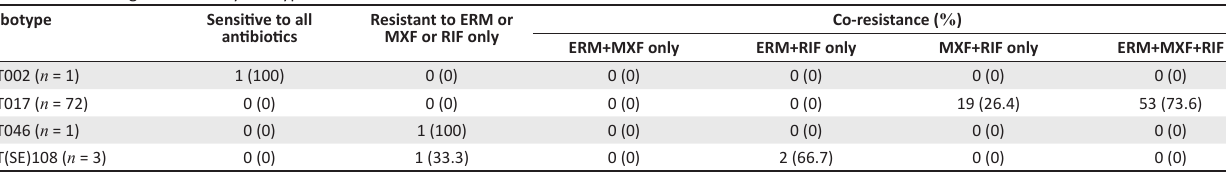
Resistant to ERM or antibiotics MXF or RIF only